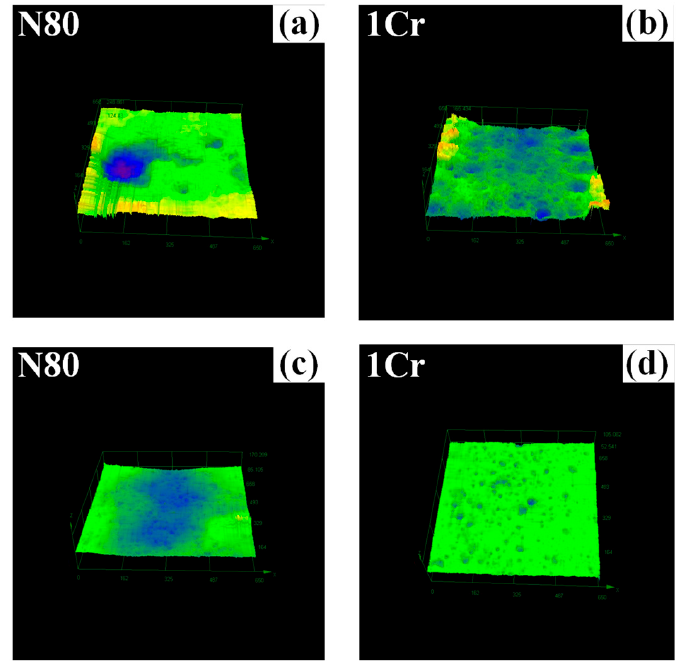
Figure 11. The pitting corrosion density micrographs at high temperature-partial pressure: ( a , b ): 100 ◦ C- CO 2 : 0.63 MPa; ( c , d ): 114 ◦ C-CO 2 : 0.73 Figure 11. The pi tt ing corrosion density micrographs at high temperature-partial pressure: ( a,b ): 100 °C-CO 2 : 0.63 MPa; ( c,d ): 114 °C-CO 2 : 0.73 MPa.